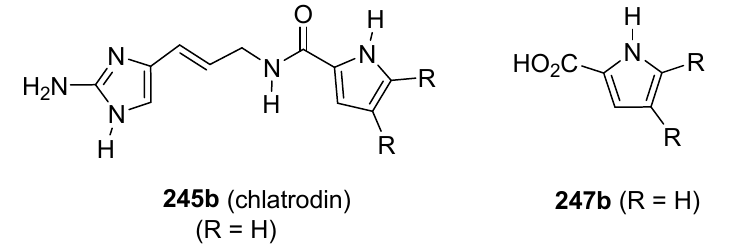
Figure 11. Structures of clathrodin ( 245b ) and 1 H -pyrrole-2-carboxylic acid ( 247b ).